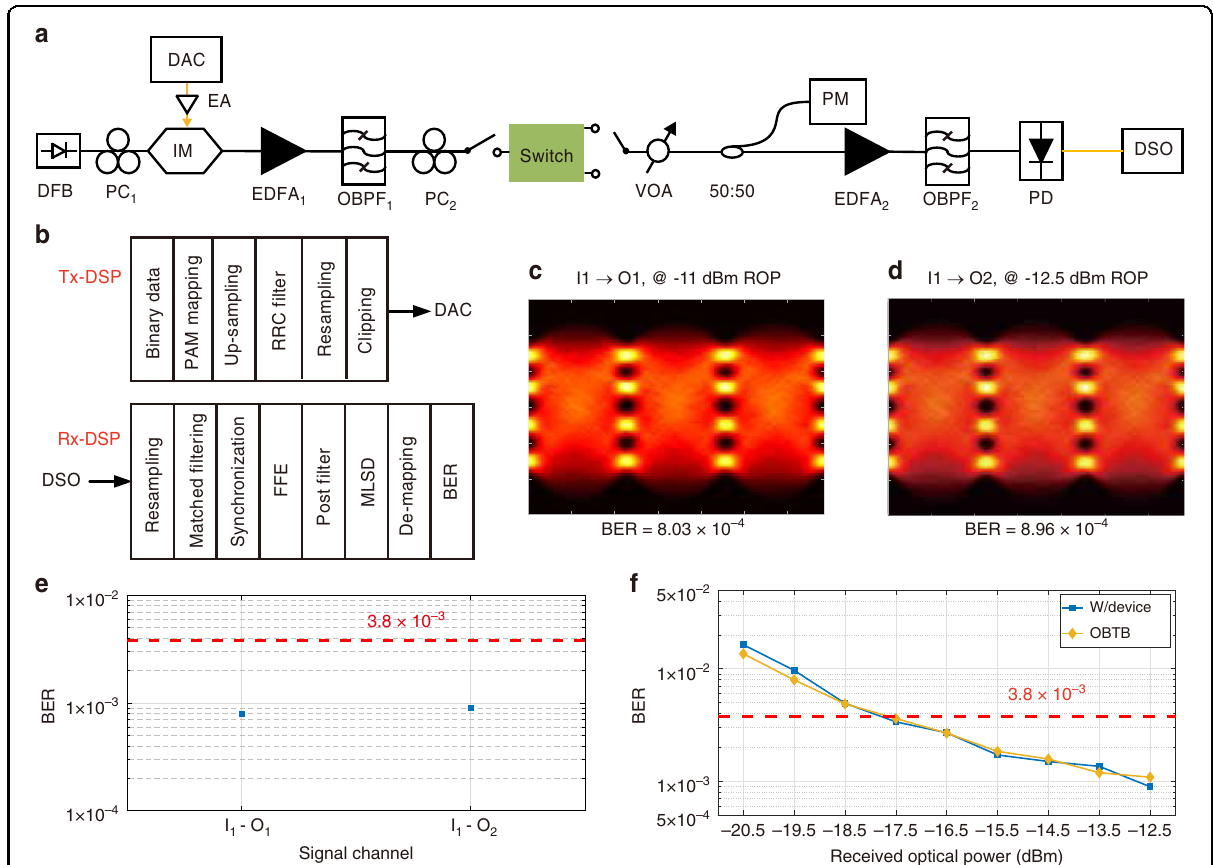
Fig. 4 High-speed data transmission experiment based on the proposed topological switch. a Experimental setup and b DSP fl ow charts for the high data rate switching of the device. PM power metre. c, d Eye diagrams for the two switching con fi gurations of the switch. e BERs of two switching con fi gurations. f BER versus received optical power